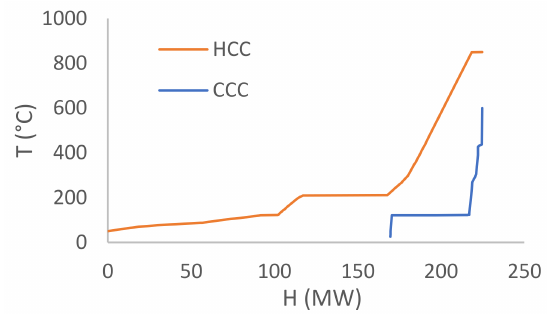
Figure 6. Composite curves.